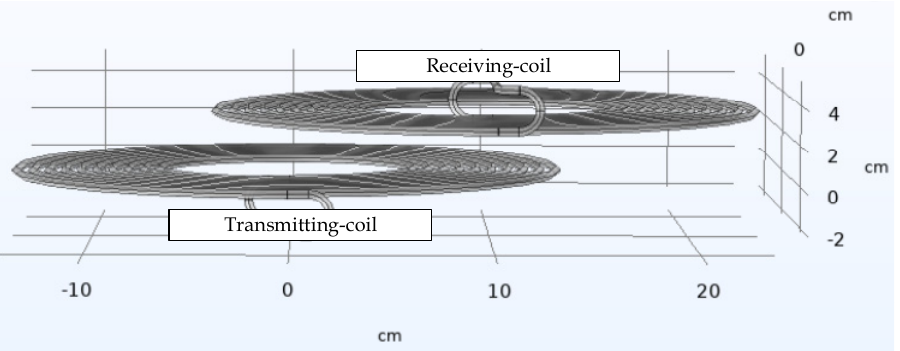
Figure 5. Geometry setup of two-coil system. Table 1. Parameters of the planar spiral coils.